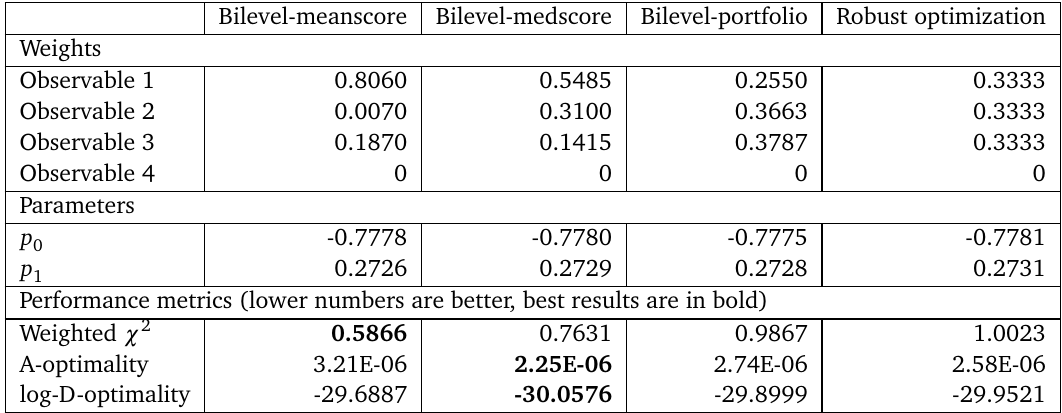
Table 11: Results for the closure test. Shown are the optimal weights obtained with each method, the optimal parameters, and the outcomes for our performance